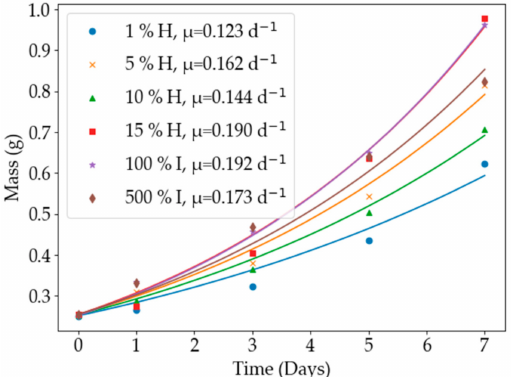
Figure 2. The average weight values are shown for each of the growth mediums, the Hoagland solution (H) and the IRR2 medium (I), along with the optimised growth curve and growth rate. The 15% strength Hoagland solution and the 100% strength IRR2 medium produced optimal